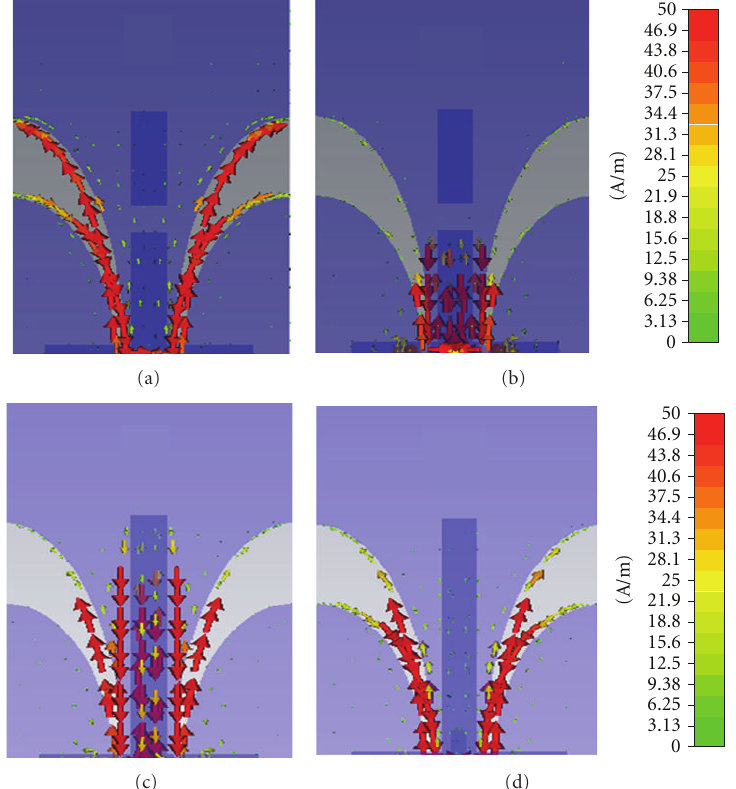
Figure 6: Simulated current distribution of the reconfigured UWB antenna in Band I: (a) 3.4GHz, (b) 5 GHz, Band II: (c) 3.4GHz, (d)